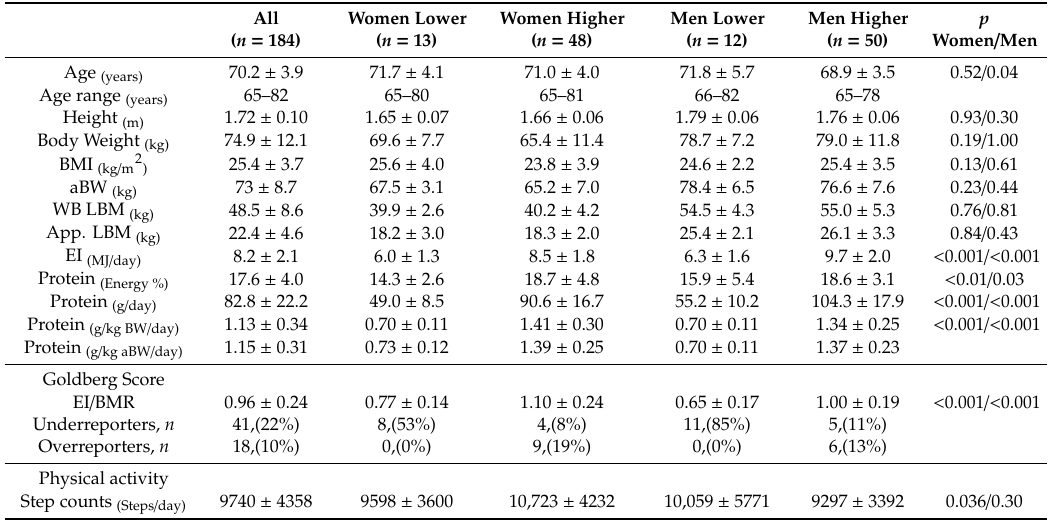
Table 1. Participant characteristics for all, and divided into sex for higher ( ≥ 1.1 g / kg aBW / day) and lower protein intakes ( < 0.83 g / kg aBW /